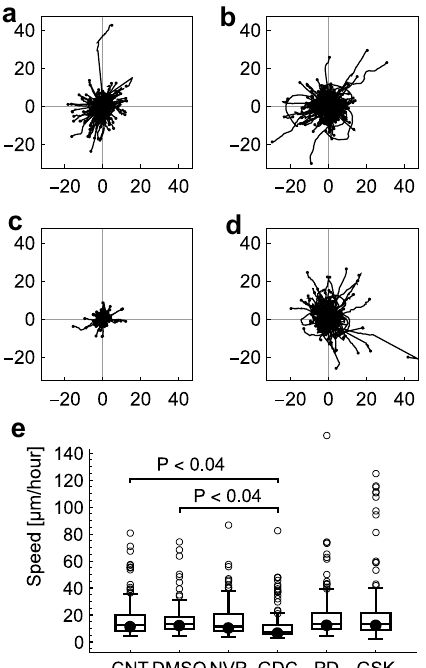
Figure 6. Rose plots of 30-min cell trajectories: ( a ) CNT, ( b ) DMSO, ( c ) GDC and ( d ) GSK. The starting points of the trajectories were shifted to a common origin. Axes are in µm. ( e ) Box and whisker plot of speed. Only GDC achieved a significant reduction of cell motility in comparison to both controls, CNT and DMSO. The plot has the same style as in Fig.